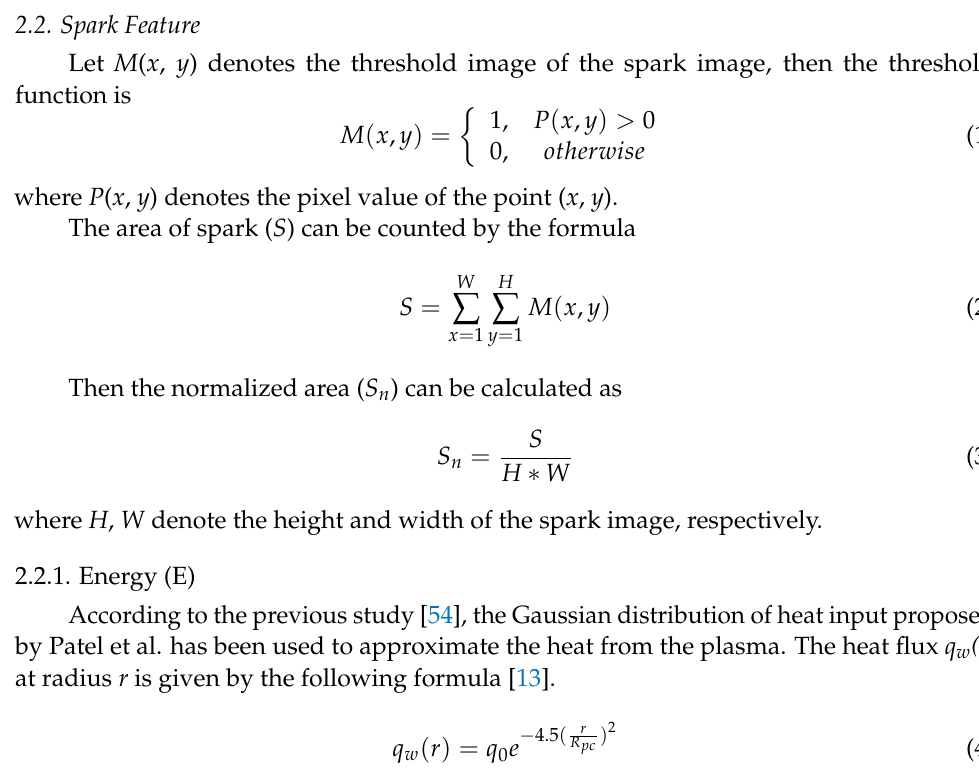
Figure 1. Spark image.